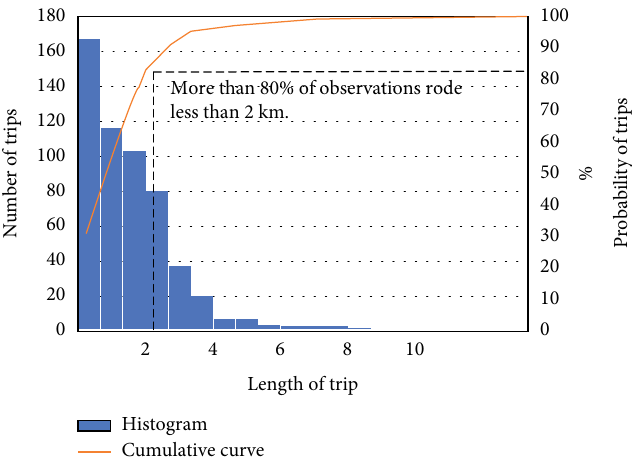
Figure 12: Distribution of route length that has been chosen.